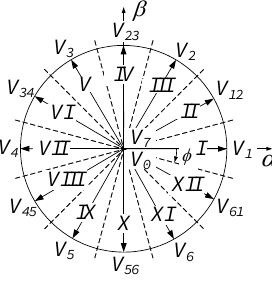
Figure 7. Twelve sectors in the two-phase static reference frame.